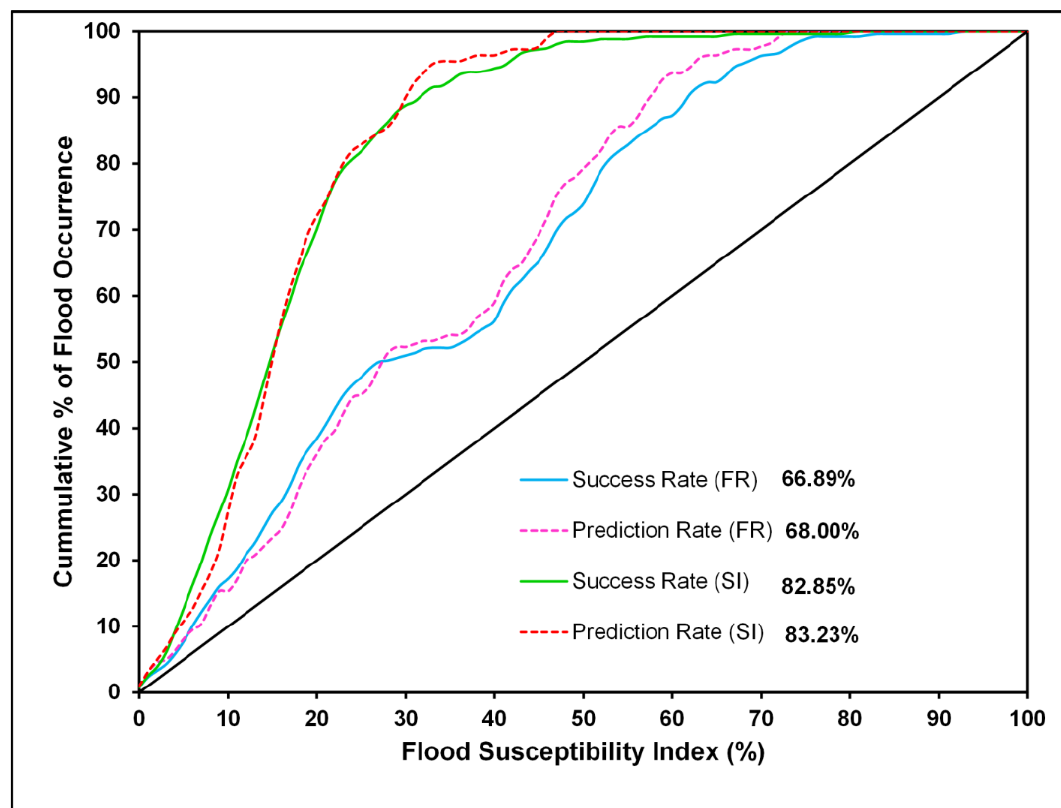
Figure 6. ROC curves of success and prediction rates of the FR and SI models.